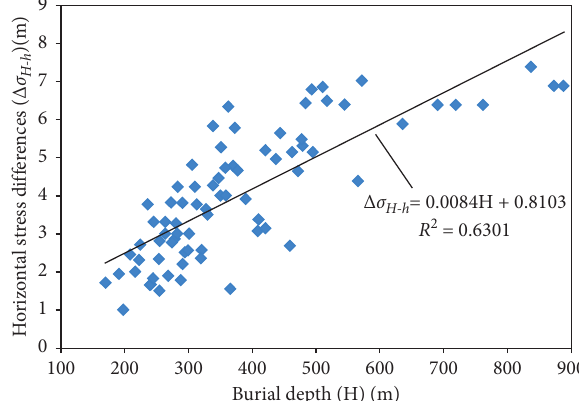
Figure 6: Scatter diagram between the horizontal stress difference ( Δ σ H − h ) and the burial